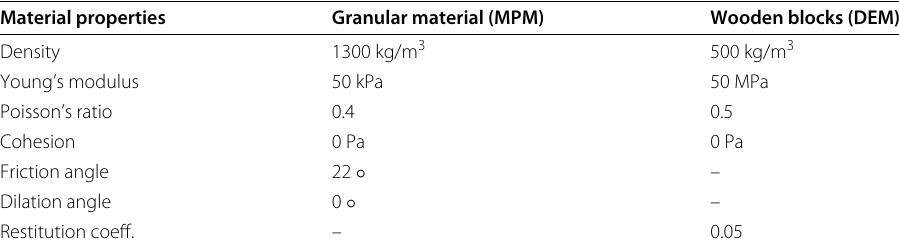
Table1 Material properties for the granular flow and the wooden blocks Material properties Granular material (MPM) Wooden blocks (DEM) Density 1300 kg/m 3 500 kg/m 3 Young’s modulus 50 kPa 50 MPa Poisson’s ratio 0.4 0.5 Cohesion 0 Pa 0 Pa Friction angle 22 ◦ – Dilation angle 0 ◦ – Restitution coeff. –